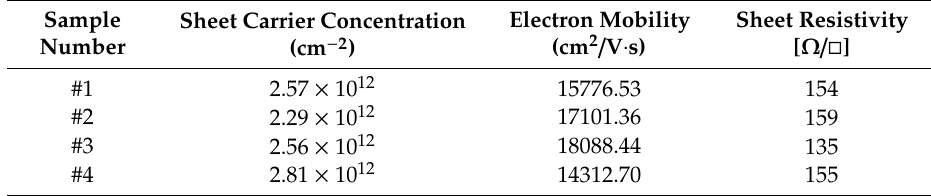
Table 2. Hall test result of the four kinds of